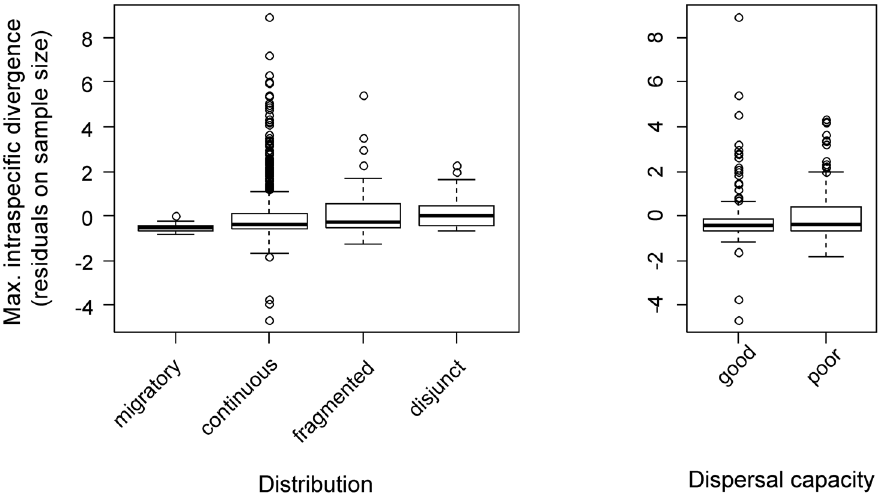
Fig. 9. Intraspecific distances in relation to distribution and dispersal capacity. Boxplots show the residuals from a regression of maximum intraspecific distance (FI + AT) against sample size. Residuals are plotted to account for among-species differences in sample size, and thus allow comparisons between distribution categories (left panel) and dispersal capacities (right